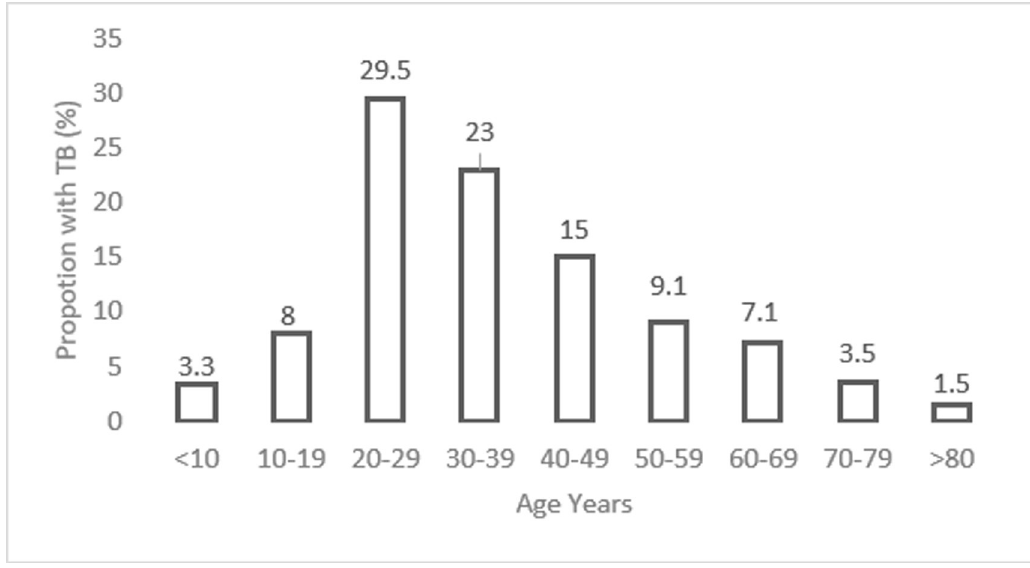
Fig 2. Age distribution of TB